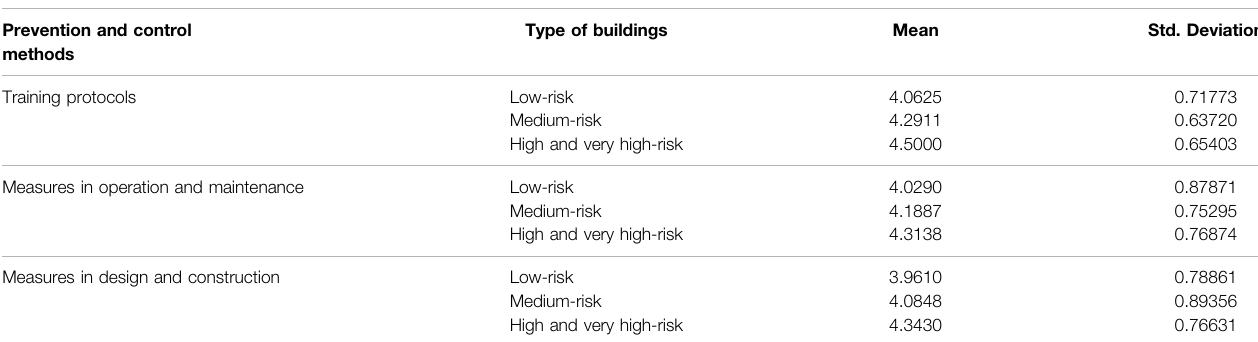
TABLE 3 | Comparison of methods classi fi cation by type of buildings.